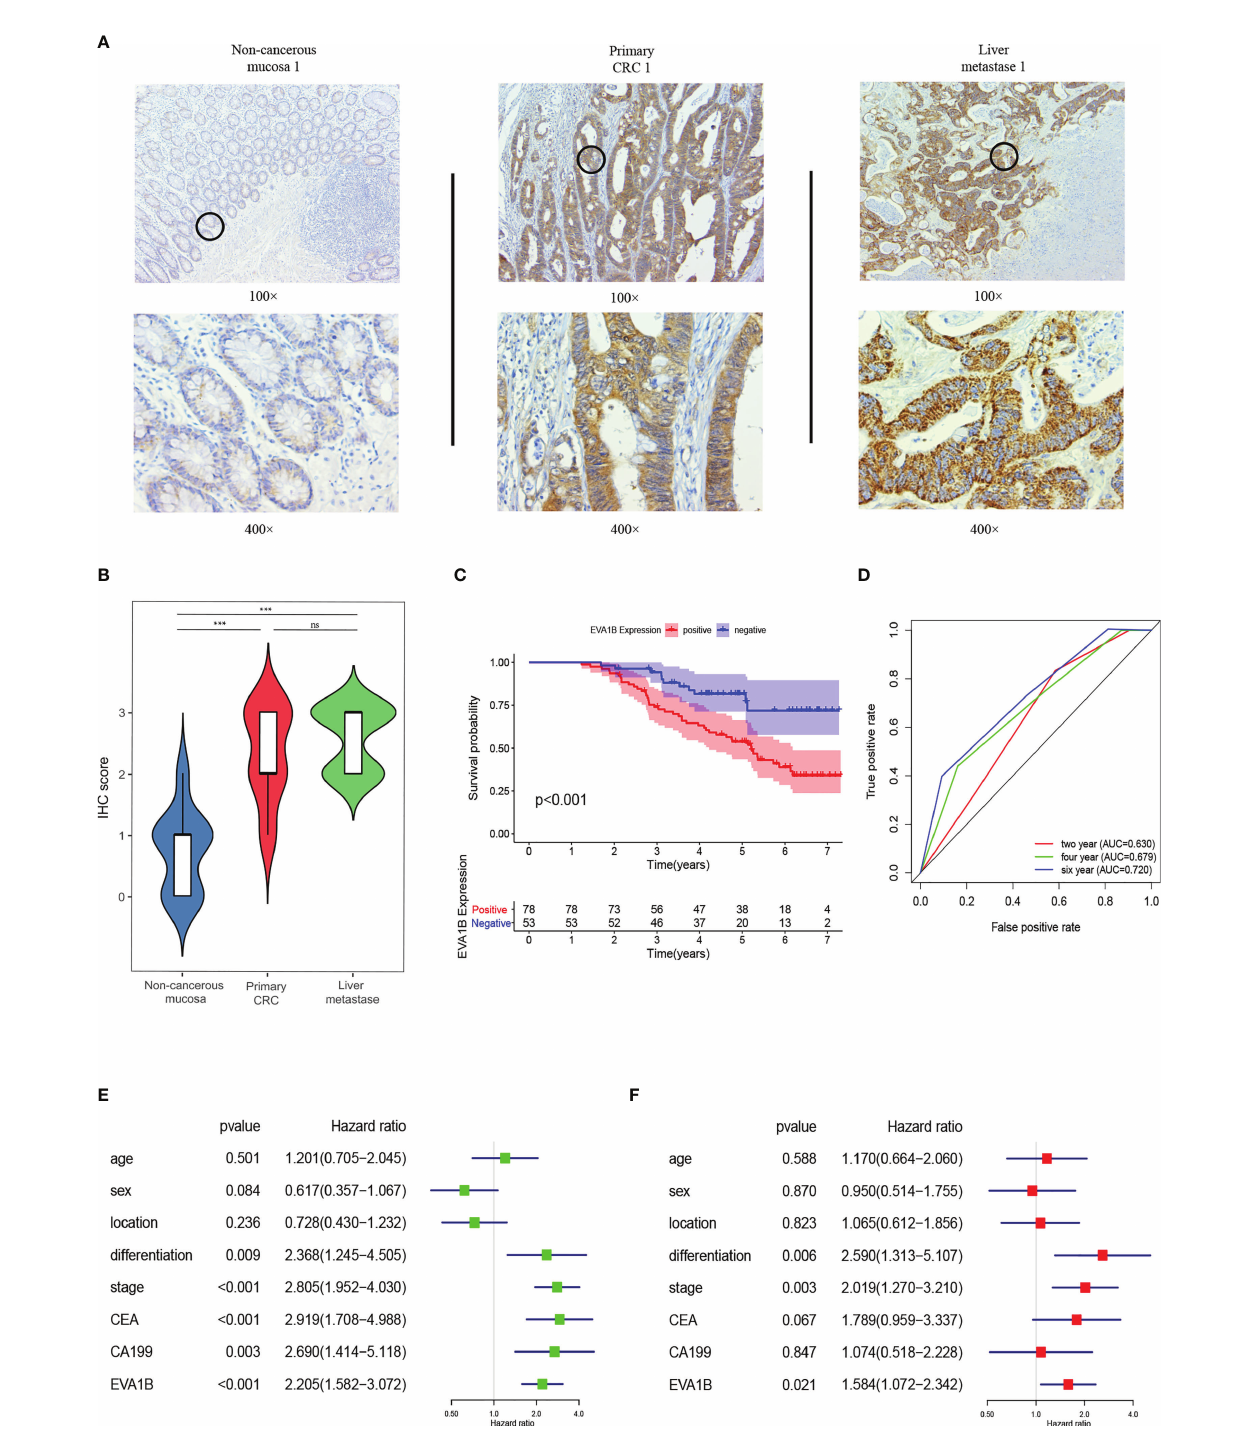
FIGURE 11 | EVA1B overexpression is correlated with CRC tumorigenesis and poor outcomes in CRC patients. (A, B) Comparison of EVA1B expression in noncancerous mucosa, paired primary CRC, and liver metastases by IHC. (C) Kaplan – Meier plots of CRC specimens with negative and positive EVA1B expression. (D) Time-dependent ROC analysis of EVA1B showing the overall survival of patients with CRC. (E, F) Univariate and multivariate Cox regression of EVA1B expression and clinical parameters in CRC. *** p < 0.001; ns, no signi fi